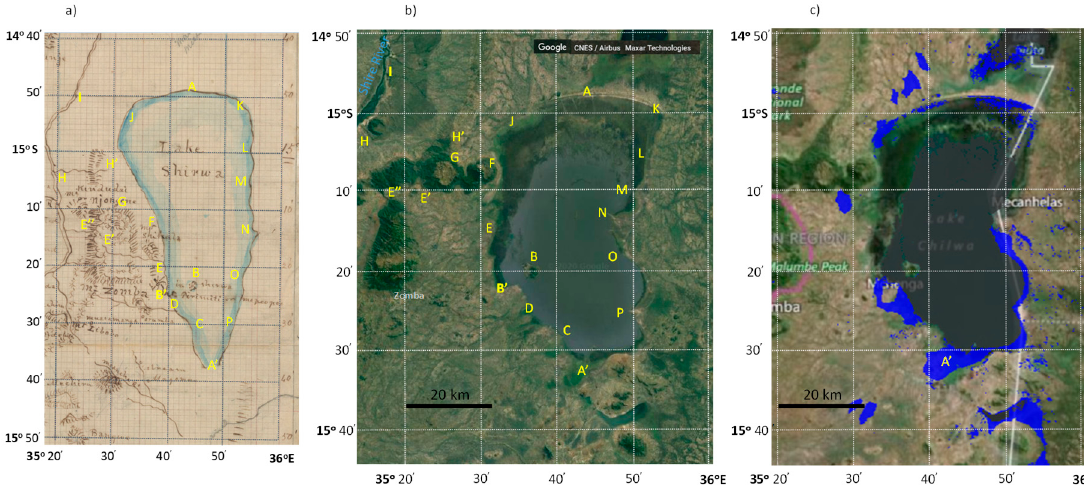
Figure 4. ( a ) Excerpt of much larger area map of Lake Nyassa (Malawi) and lake Shirwa (Chilwa) drawn by the Scottish explorer Dr David Livingstone in c . 1864 [52] showing the Lake Chilwa area with longitude and latitude lines re-drawn over original lines and location labels A to P added (Images © National Library of Scotland. Creative Commons Share-alike 2.5 UK: Scotland (https: // creativecommons.org / licenses / by-nc-sa / 2.5 / scotland / ). As relevant, © Dr. Neil Imray Livingstone Wilson. Creative Commons Attribution-NonCommercial 3.0 Unported (https: // creativecommons.org / licenses / by-nc / 3.0 / )); ( b ) Google Earth satellite image (August 2020 download) of Lake Chilwa area with added location labels; ( c ) Satellite image of Lake Chilwa flooding extent and persistent water wetlands at 90-m scale for 10 March 2019 Satellite-derived flood extent, persistent water, and wetlands at 90-m scale for 10 March 2019 (source: Atmospheric and Environmental Research, http: //